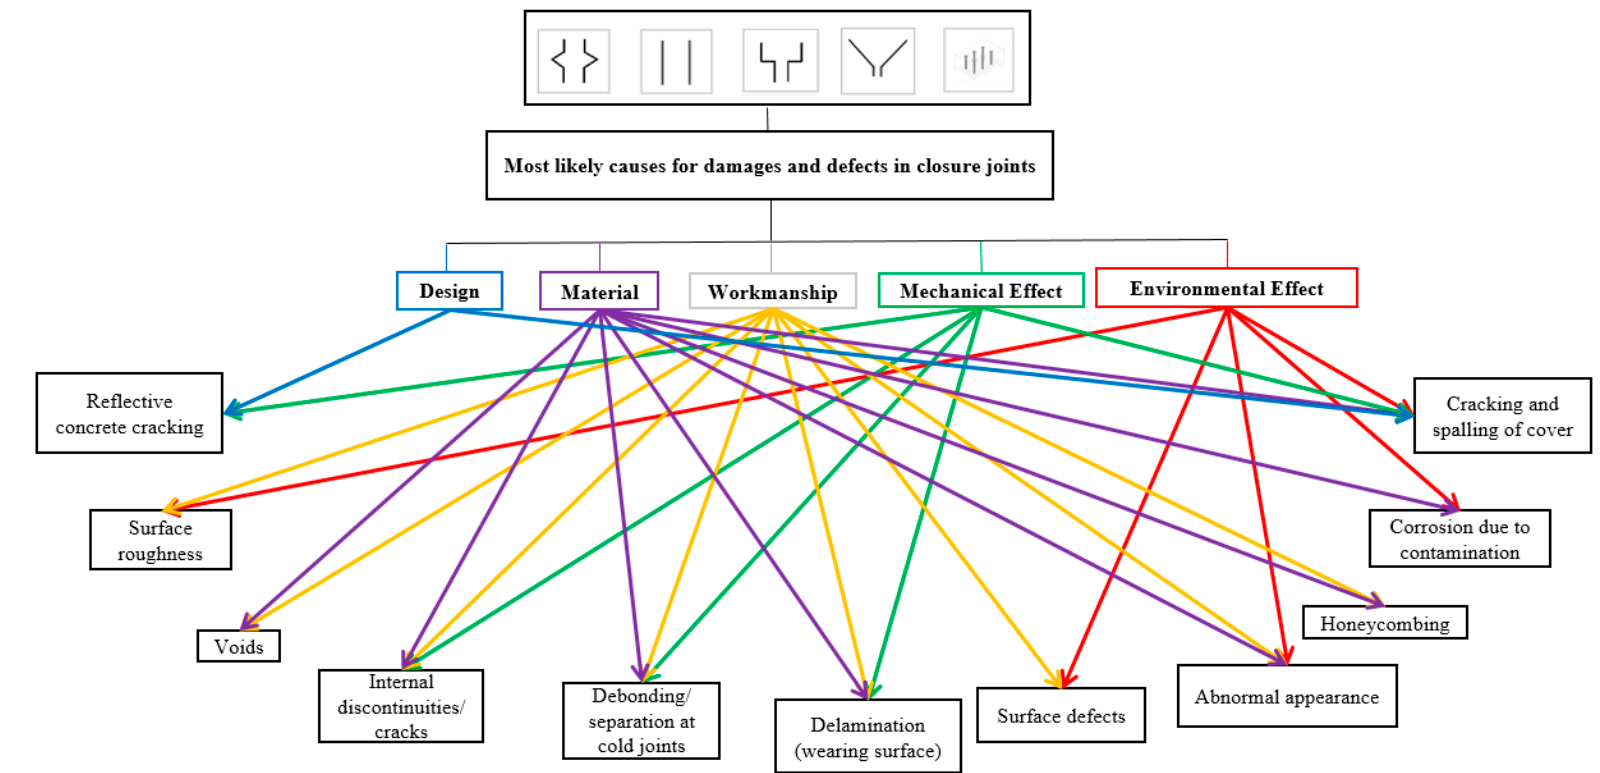
Figure 4. The most likely causes for damage and defects in ABC closure joints.